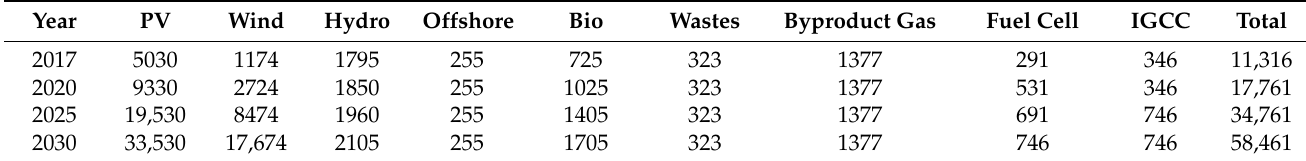
Table 1. Renewable energy capacity expansion plan in Korea by 2030 (MW).